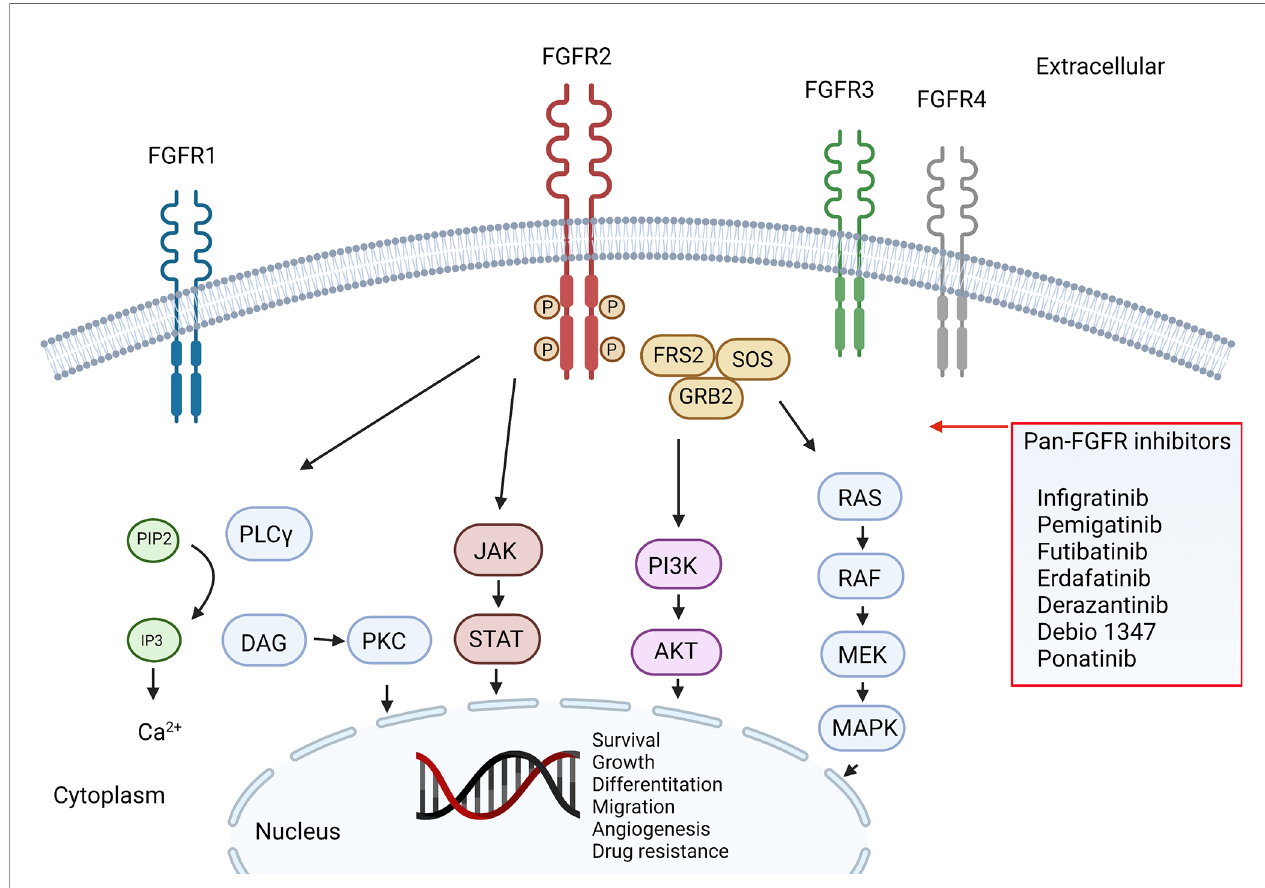
FIGURE 1 | FGFR pathway and